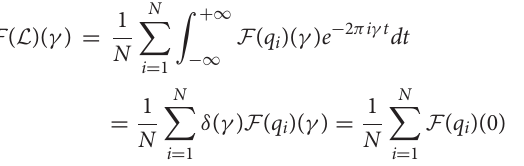
augmentations, will impact the frequency content observed in the